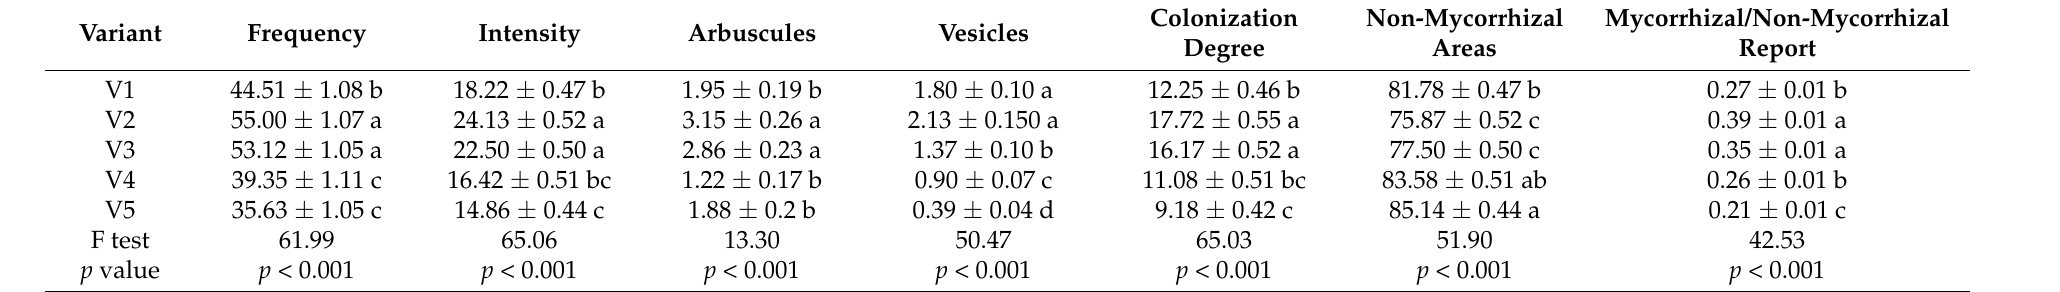
Table 1. Differences in mycorrhizal parameters in roots of F. rubra induced by long-term treatments.